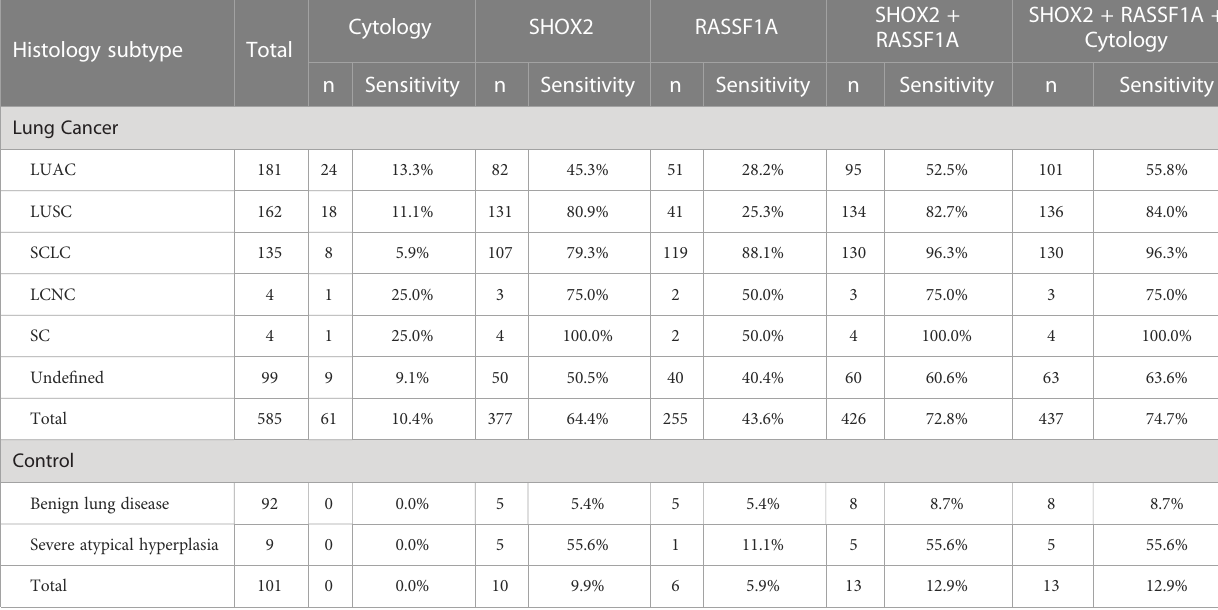
TABLE 3 Detection sensitivity of cytology and SHOX2 and RASSF1A methylation panel in different histological subtype groups.